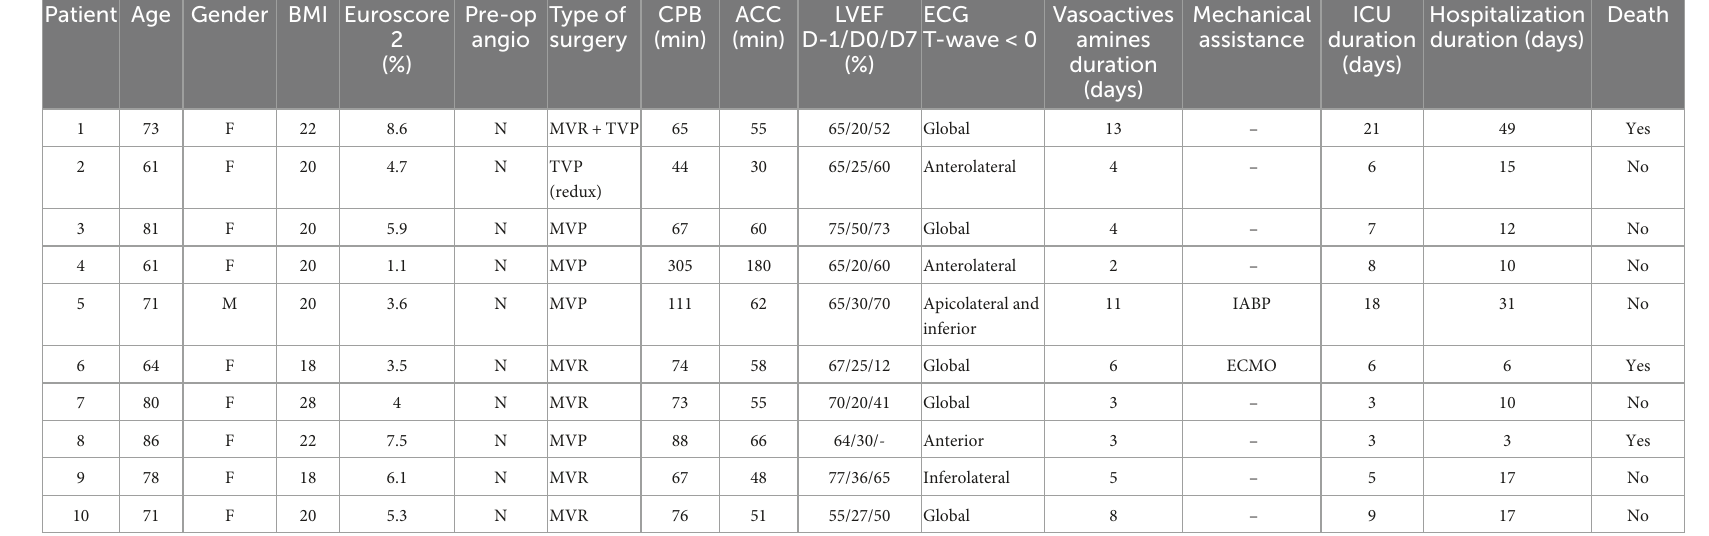
TABLE 1 Characteristics and outcomes of our institution’s post-operative takotsubo